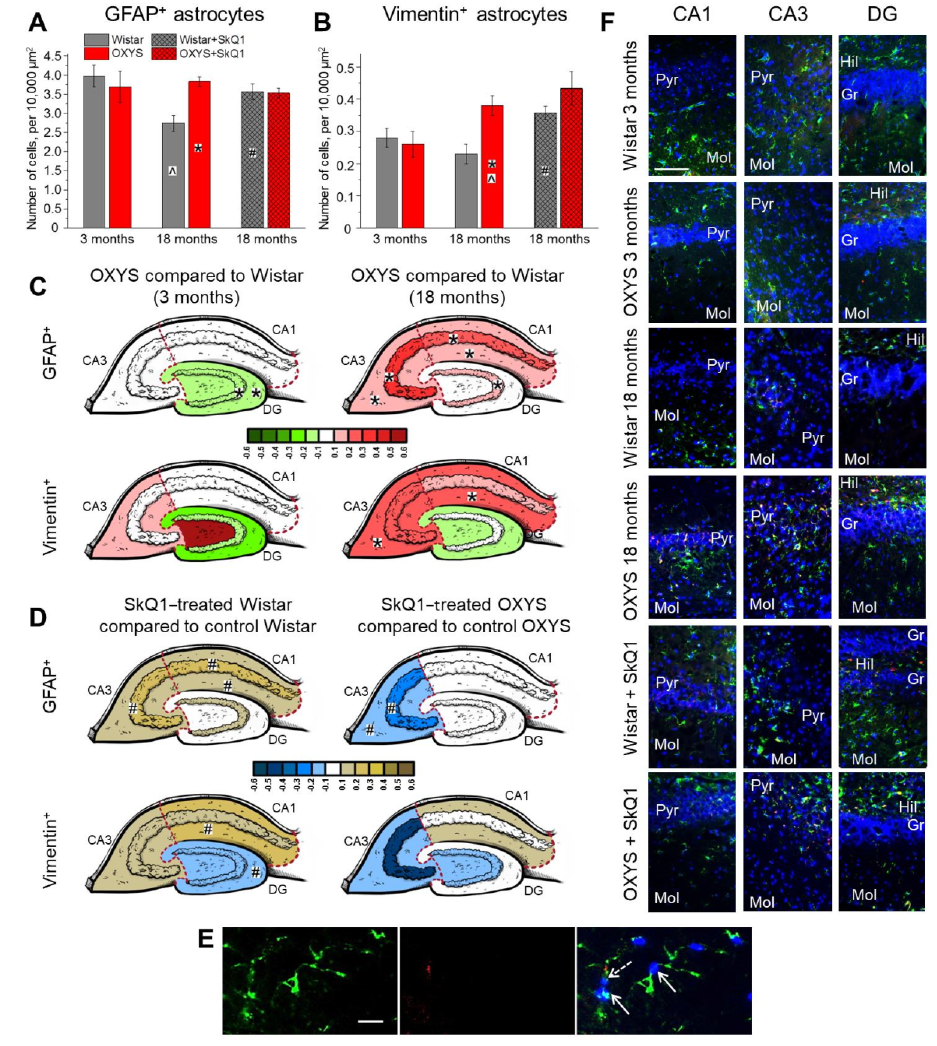
Figure 2. The density of GFAP + ( A ) and vimentin + ( B ) astrocytes in the hippocampus of OXYS and Wistar rats at 3 and 18 months of age, as well as after SkQ1 treatment. Changes in GFAP + and vimentin + cell density in the regions of hippocampus of OXYS rats compared to Wistar rats ( C ) and in SkQ1-treated compared to untreated animals ( D ) are presented schematically. GFAP + and vimentin + cell density in each region and layer is coded as a heatmap on an lg scale from − 0.6 to 0.6. ( E ) A representative image of GFAP + cells (green; indicated by the arrow) and vimentin + cells (red; indicated by the dashed arrow) (the molecular layer of the CA1 area in the hippocampus of a Wistar rat at 3 months of age). The scale bar is 20 µ m. ( F ) Images of GFAP + cells (green) and vimentin + cells (red) in the hippocampal regions of OXYS and Wistar rats at 3 and 18 months of age, as well as after SkQ1 supplementation; the scale bar is 100 µ m. 4 (cid:48) ,6-Diamidino-2-phenylindole (DAPI, blue) indicates cell nuclei ( E , F ). Gr: granular layer; Hil: hilus; Mol: molecular layer; Pyr: pyramidal layer. The data ( A , B ) are presented as mean ± SEM; * p < 0.05 for differences between the strains; ˆ p < 0.05 for differences from a previous age; # p < 0.05 for effects of SkQ1